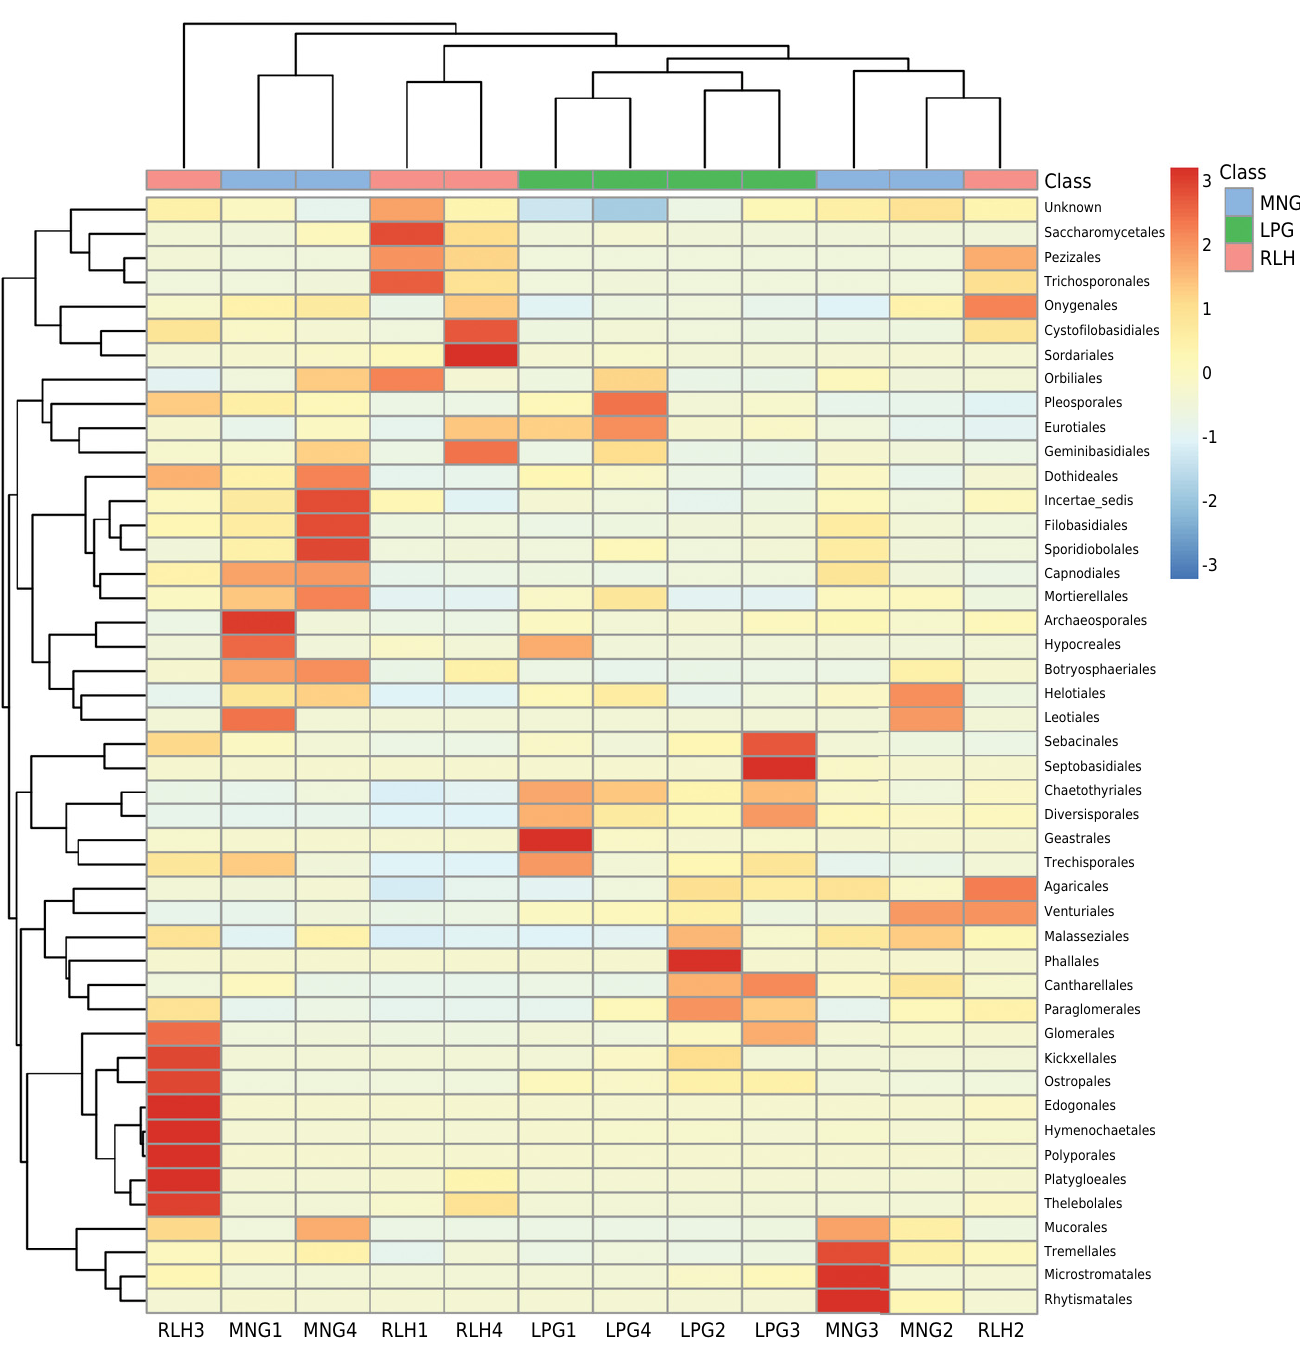
Figure 6. Heatmap analysis of the fungal community of soil samples subjected to RLH, LPG, and MNG treatments collected at four times during the year and multiple samples similarity tree at the order level. The connecting lines on top describe the fungal communities clustering of each sample. The connecting lines on the left side describe the clustering of each fungus. The closer the color close to red was, the more dominant microorganism was. Note: RLH: raising laying hens under forest; LPG: cultivating Lolium perenne grass under forest; MNG: maintenance of native grass under forest. The number after the treatment symbol means: 1 = spring; 2 = summer; 3 = autumn; 4 =